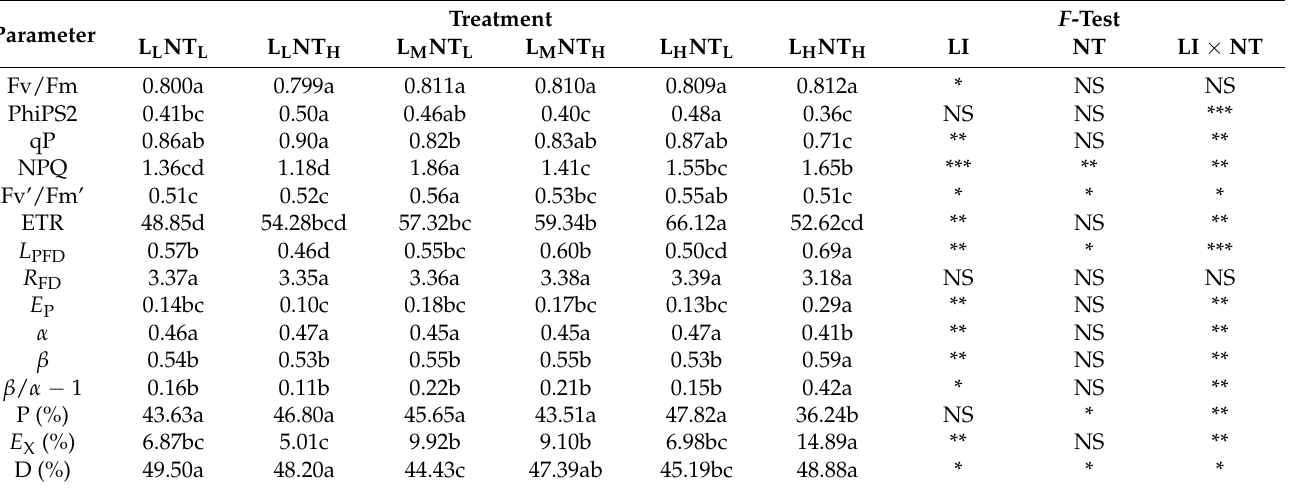
Table 1. Effect of light intensity (LI) and night temperature (NT) on Chl fluorescence parameters of cherry tomato seedlings and LI and NT interaction